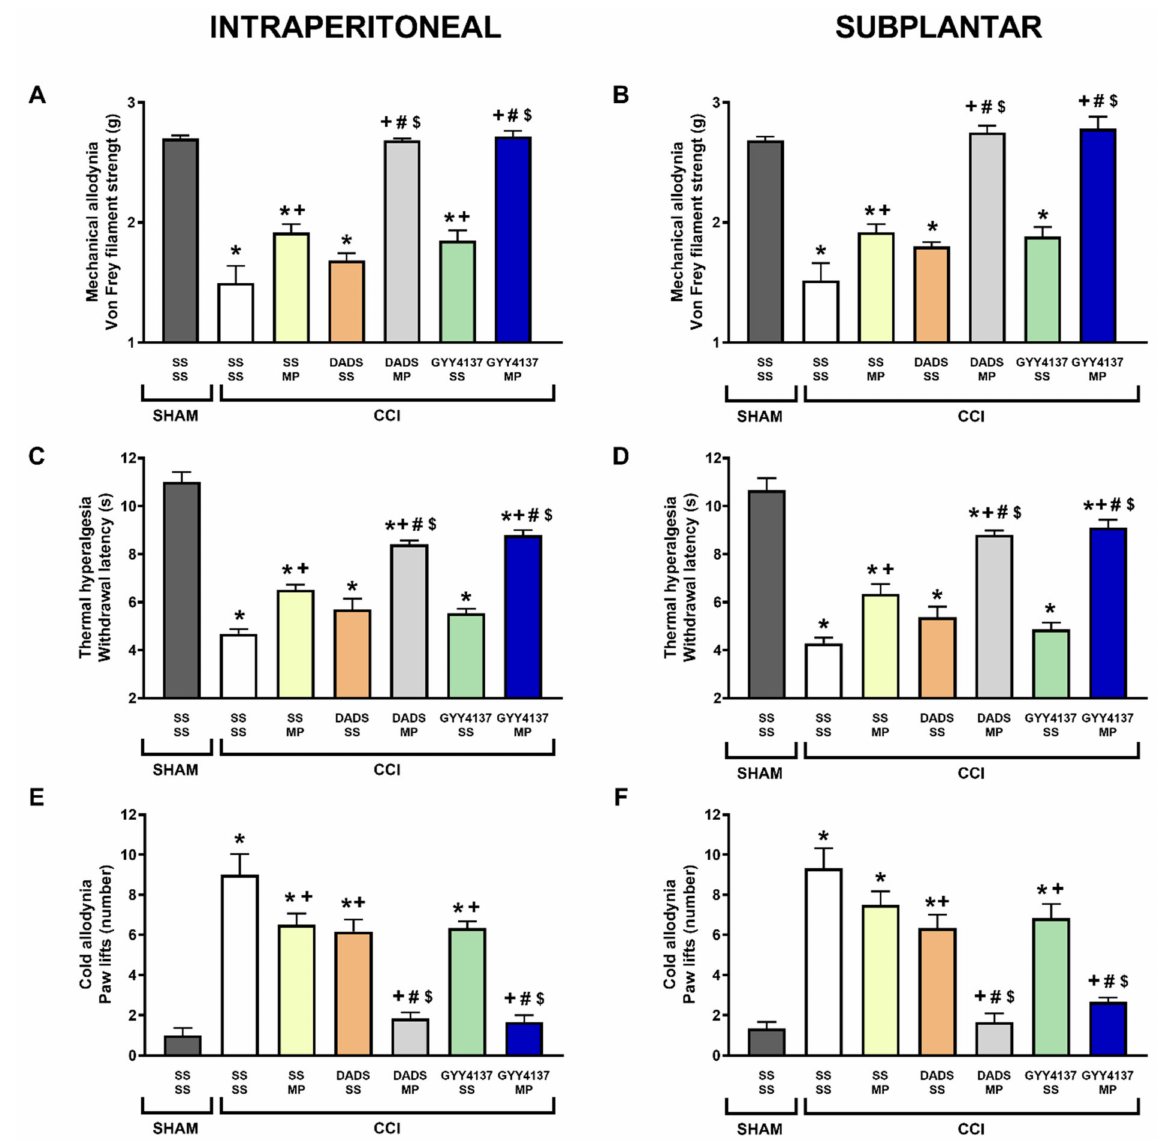
Figure 1. Effects of the co-administration of DADS or GYY4137 with morphine on the mechanical allodynia, thermal hyperalgesia, and cold allodynia induced by nerve injury in mice. Effects are represented of the i.p. administration of 3.5 mg/kg of DADS or 0.7 mg/kg of GYY4137 combined with 3 mg/kg or 65 µ g of morphine (MP), intraperitoneally or subplantarly injected, on the mechanical allodynia ( A , B ), thermal hyperalgesia ( C , D ), and cold allodynia ( E , F ) provoked by sciatic nerve injury (CCI) in the ipsilateral paws. The effects of these treatments administered alone are also represented. Sham-operated (SHAM) animals treated with SS plus SS are also represented. For each test, * represents significant differences vs. SHAM-animals treated with SS plus SS, + vs. CCI-mice treated with SS plus SS, # vs. CCI-mice treated with SS plus MP and $ vs. CCI-mice treated with DADS or GYY4137 plus SS ( p < 0.05; one-way ANOVA, followed by Tukey test). Each column represents the mean, and vertical bars indicate SEM ( n = 6 animals for